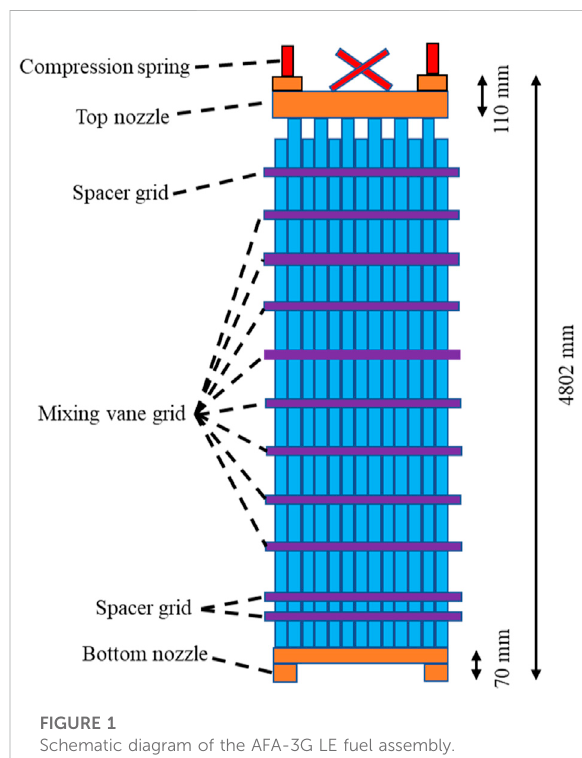
FIGURE 1 Schematic diagram of the AFA-3G LE fuel assembly.